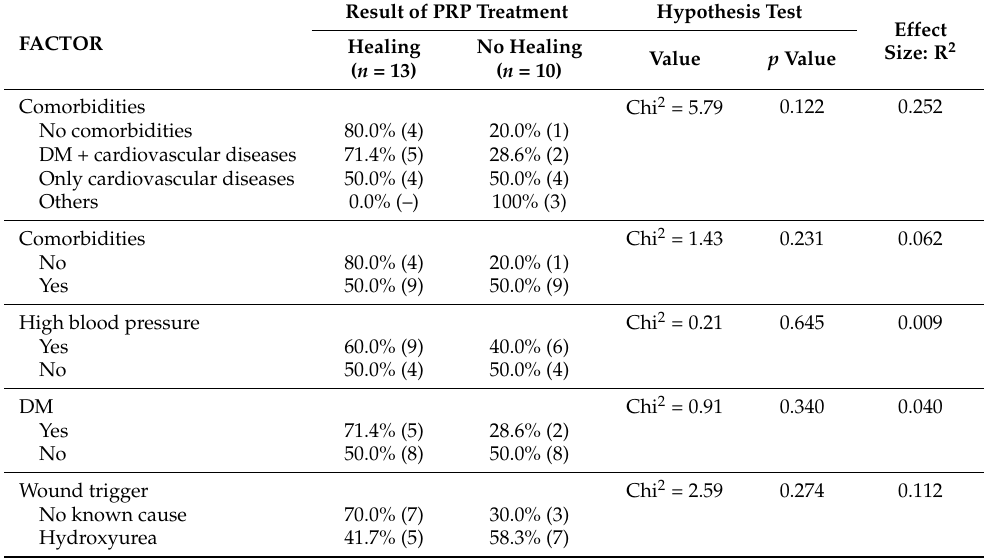
Table 3. Medical history-related factors associated with wound healing in patients treated with PRP ( N = 23